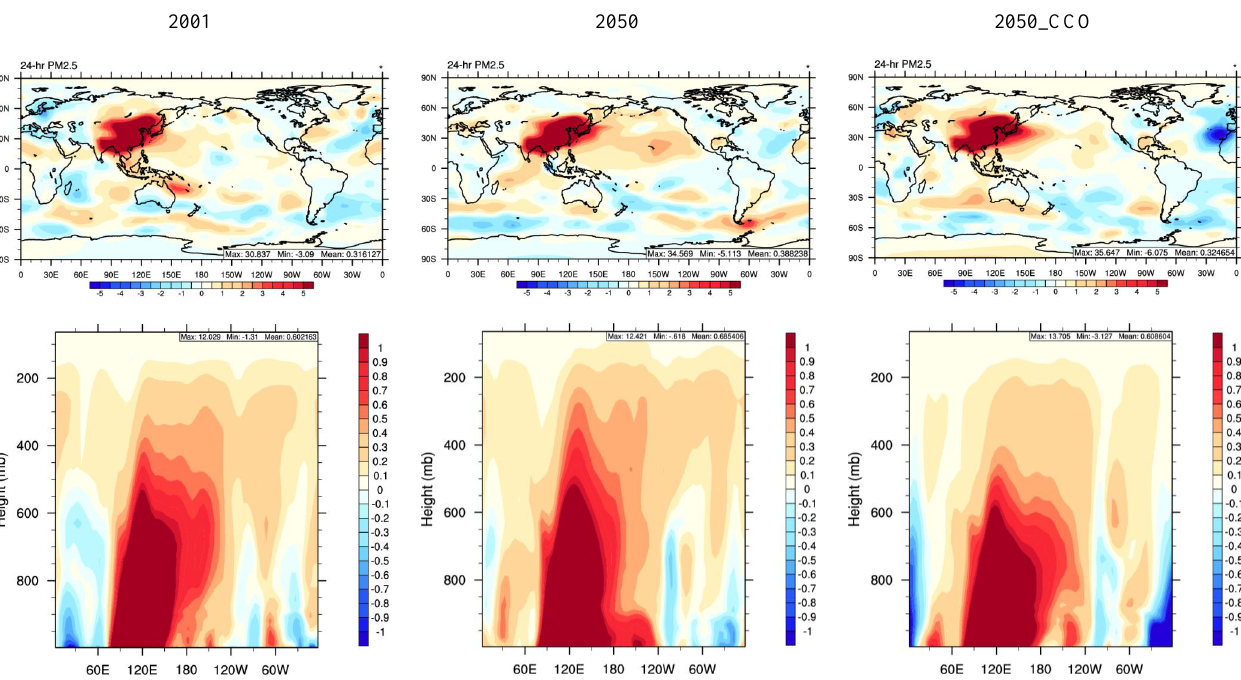
Figure 7. The difference in the spring (MAM) 24-hr average PM 2.5 concentration (top) and the mid-latitude (24°N to 60°N) meridional averaged vertical cross section of PM 2.5 (bottom) between the simulations with and without EAAEs for the current (2001) and future (2050 and 2050_CCO) scenarios.